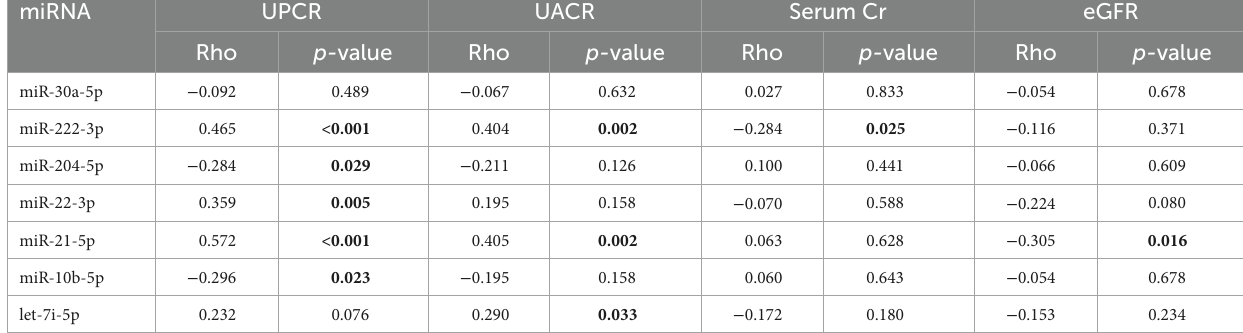
TABLE 3 Correlation between biochemical parameters and expression of miRNAs derived from uEVs in a validation cohort. miRNA UPCR UACR Serum Cr eGFR Rho p- value Rho p- value Rho p- value Rho p-